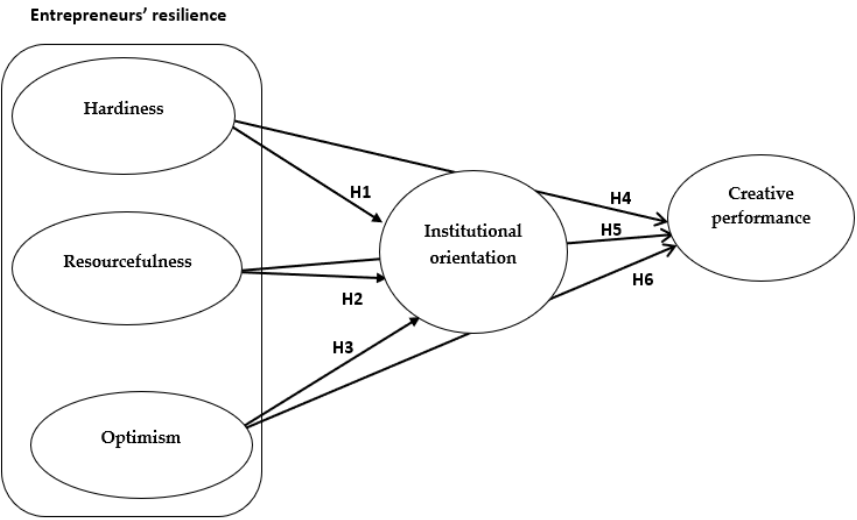
Figure 1. Research Figure 1. Research framework.